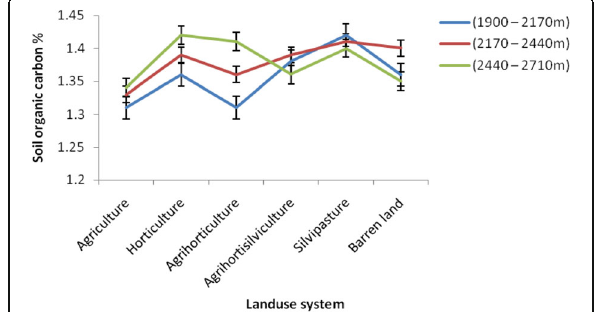
Fig. 3 Variation of SOC (%) in different land use systems along altitudinal